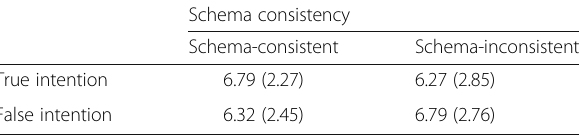
Table 2 Means (and SDs) of the dependent measure (number of object categories) by type of intention and schema